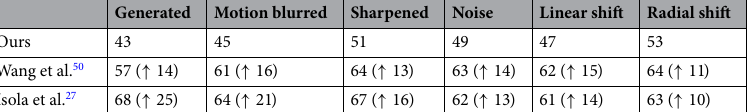
Generated Motion blurred Sharpened Noise